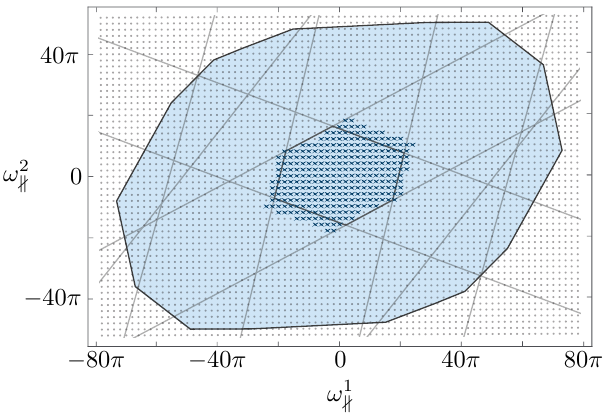
-coordinates containing all ,